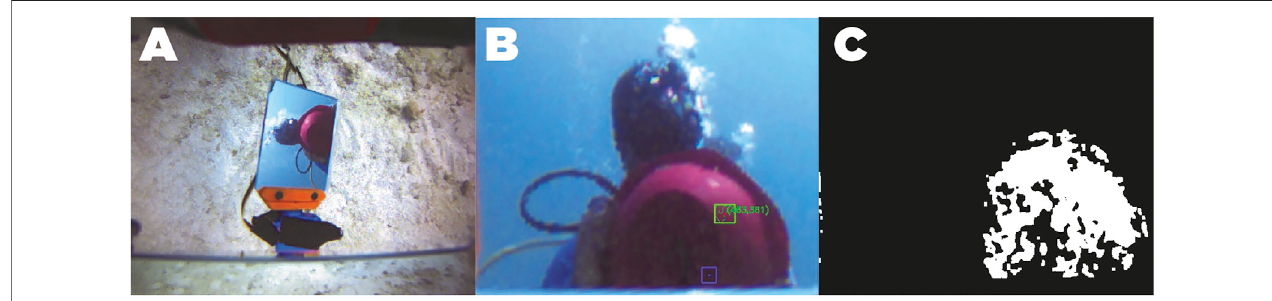
Frontiers in Robotics and AI |